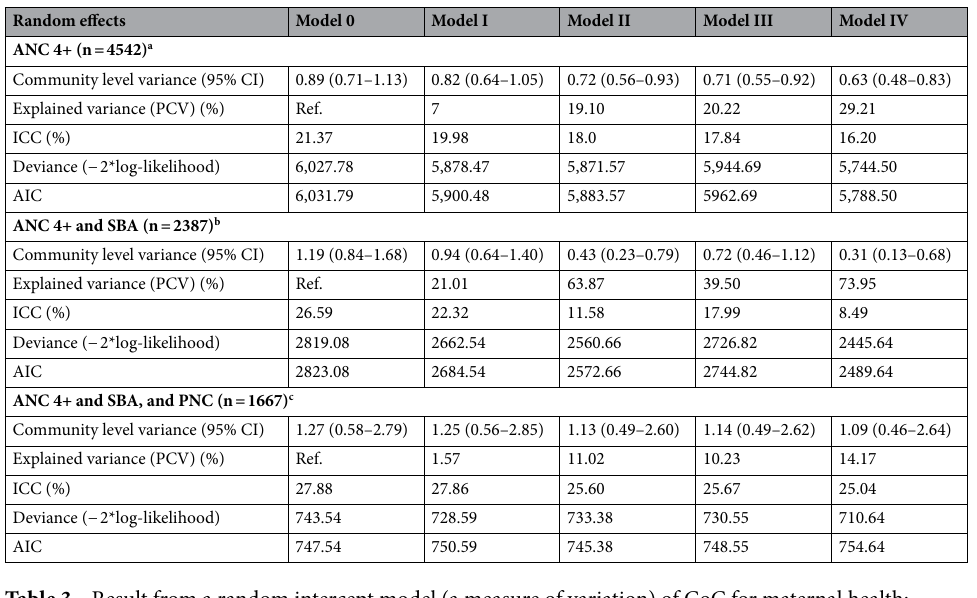
Our three outcomes had ICCs of 21.37%, 26.59%, and 27.88% in the null model, respectively. In other words, variances between clusters were responsible for 21.37%, 26.59%, and 27.88% of the variation in CoC from at least one ANC to ANC 4+ visits, pregnancy to SBA, and delivery to the early postnatal period in women (between- cluster variation). Furthermore, the ICC revealed that after adjusting individual, household, and community level variables for models that predicted ANC 4+ visits, CoC from pregnancy to SBA, and CoC from delivery to the early postnatal period, about 16.20%, 8.49%, and 25.04% of total variation remained unexplained. Table 3 further reveals that the PCV rises from 7.86%, 21.01%, 1.57% (Model I) to 29.21%, 73.95%, and 14.17% (Model IV), implying that Model IV best describes the variability of our three desired outcomes. Fur- thermore, Model IV has the lowest − 2LL and AIK value for all three outcomes. As a result, it was chosen as the best-fitting model. Associations of CoC with the dimensions of women’s empowerment along with other indi- vidual, household, and community level factors (fixed effects). After adjusting for individual, household, and community-level characteristics for our three desired outcomes, Table 4 shows the odds ratio of the full model (Model IV) for relationships between CoC and the dimensions of women’s empowerment. Because the model had a greater goodness of fit, the results from Model IV for the three outcomes are reported (i.e., lower deviance). Full model (Model IV) that predicted ANC 4+ visits in women who had at least one ANC shows that women with medium (adjusted odds ratio [AOR] 1.23; 95% confidence interval [CI] 1.06–1.43) or high social independ- ence (AOR 1.97; 95% CI 1.58–2.47) had 23% and 97% more ANC 4+ visits than women with low social inde- pendence. When comparing urban residents and women from rich families to rural residents and women from poor families, having four or more ANC visits was 33% and 126% higher, respectively. ANC 4+ visits were 25% less likely in grand multiparous women (≥ 3 parity) and women who had an unwanted pregnancy, respectively, than in single parity women and women who had an intended pregnancy. The odds of receiving ANC 4+ visit drop by a factor of 0.96 as the distance to a nearby health facility increases by one unit. When women used cng/ baby taxis or other modes of transportation (motor lunch, animal cart, bicycle, boat, train etc.), they were 36% and 38% less likely to have ANC 4+ visits, respectively, than when they used rickshaw/van. Full model (Model IV) that predicted the CoC from pregnancy to SBA in women who had received four or more ANC shows that women with medium (AOR 1.28; 95% CI 1.02–1.60) or high (AOR 2.76; 95% CI 1.94–3.94) social independence had a higher likelihood of remaining in SBA than women with low social independence. Furthermore, women with high negative attitude to violence dimensions were 85% more likely to likely to be retained in SBA than women with low negative attitude to violence domains. In terms of other individual, household, and community level factors women who were in the middle (AOR 1.85; 95% CI 1.44–2.39) or rich